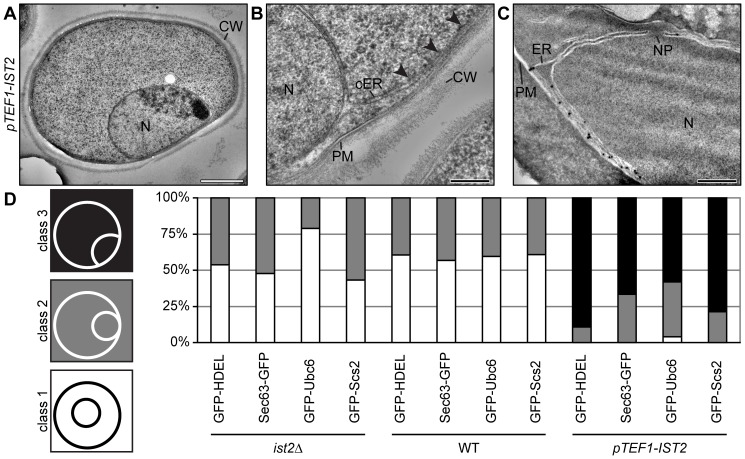
Overexpression of Ist2 traps the perinuclear ER at the PM.(A–C) Electron micrographs of log phase pTEF1-IST2 cells. (A and B) Cells were high pressure frozen, freeze substituted and Epon embedded. (B) Arrowheads indicate the association of cortical ER with the PM. (C) Immuno-gold labeling of chemically fixed cells using anti-Ist2 antibodies. Organelles and membranes are labeled (PM, plasma membrane; CW, cell wall; ER, endoplasmic reticulum; N, nucleus; NP, nuclear pore). The white bar corresponds to 1 µm and the black bar to 200 nm. (D) Association of nuclei analyzed by CLS microscopy of ist2Δ, WT, and pTEF1-IST2 cells expressing GFP-HDEL (n = 39, 38, 55), Sec63-GFP (n = 46, 60, 48), GFP-Ubc6 (n = 66, 54, 50), and GFP-Scs2 (n = 52, 74, 95). Class 1 cells have the nucleus in the centre without any contact to the periphery (white), class 2 cells have the nucleus in contact with the periphery (grey), and class 3 cells have a deformed nucleus that aligns with the periphery (black). Quantification was performed with blinded data.